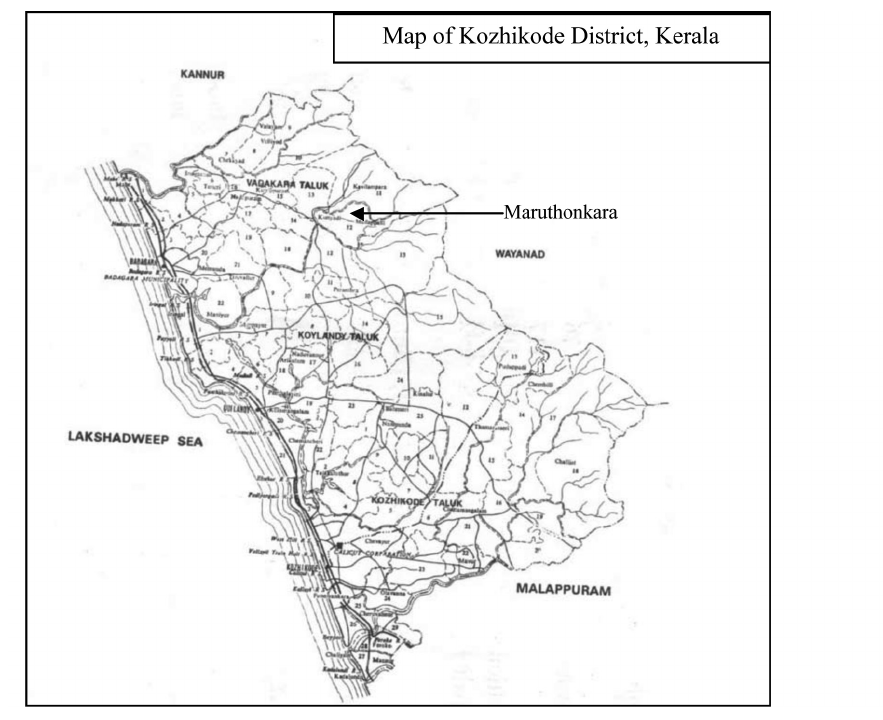
Source: Source: http://www.kkd.kerala.gov.in/district.htm